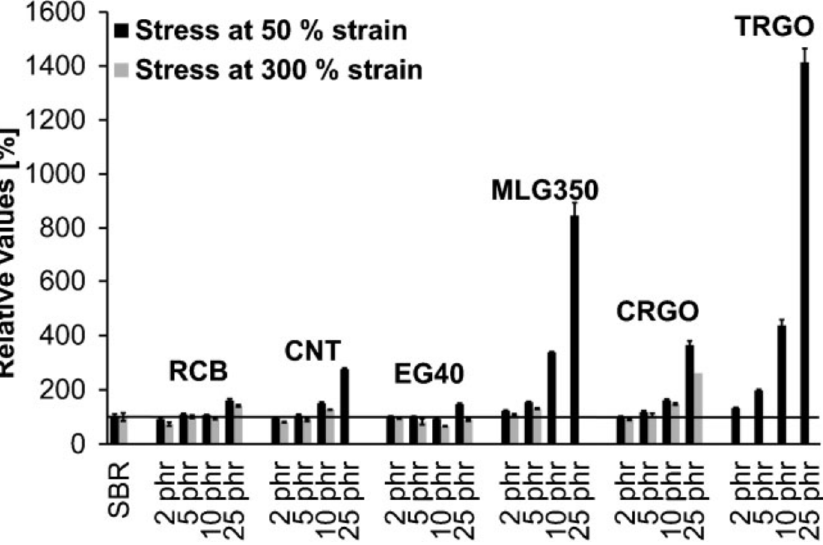
Figure 10. Stress at 50% and 300% strain of styrene butadiene rubber (SBR)/C based fillers as relative values compared to neat SBR. Reproduced with permission from [79], Copyright Wiley, 2014.